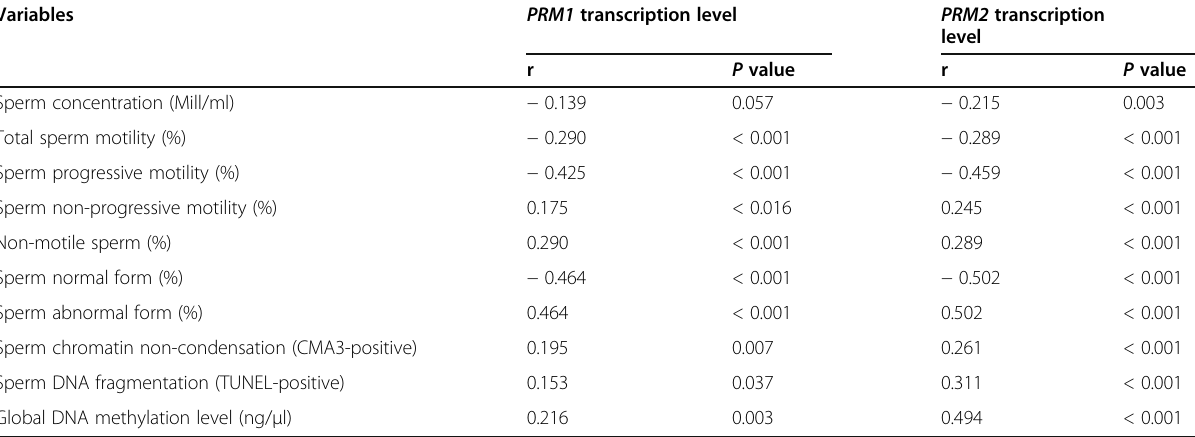
Table 5 Correlation between the transcription level of protamines and semen parameters